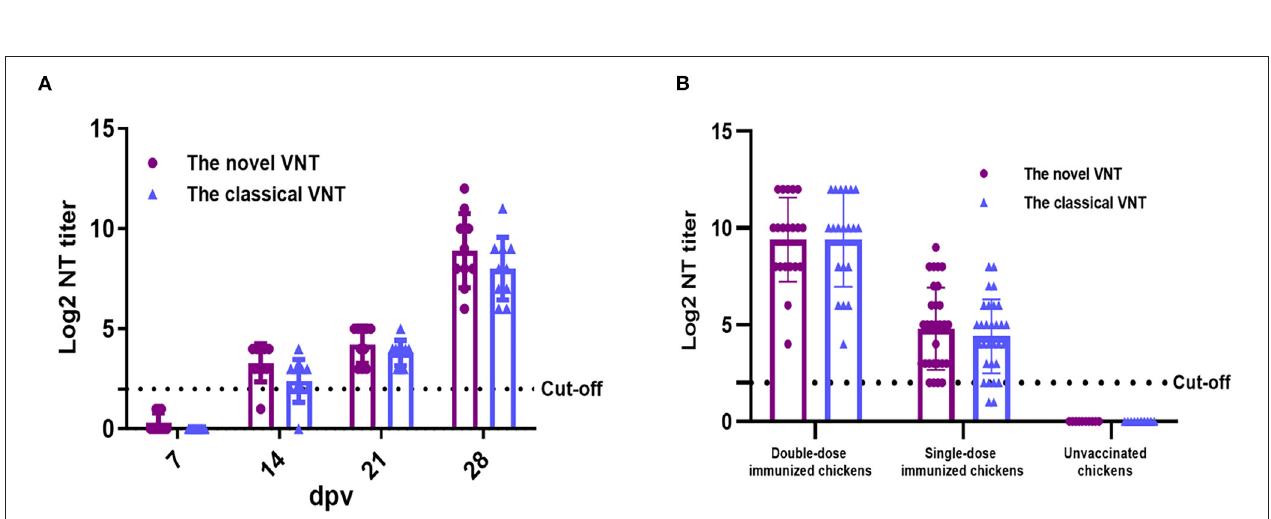
FIGURE 3 | The novel VNT for detection of sera from chickens ( n = 5) experimentally infected with FAdV-4. (A) Sera were collected and tested at 0, 7, 14, 21, and 28 d post infection (dpi) by both the novel VNT and the classical VNT. (B) The correlation coefficient of experimental sera tested with the classical VNT and the novel VNT was 0.9361.